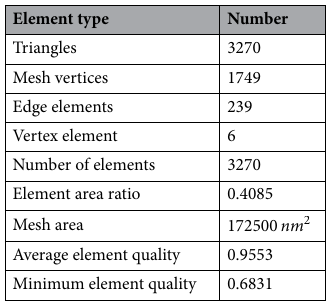
Table 1. Element statistics of the used mesh in our numerical model.